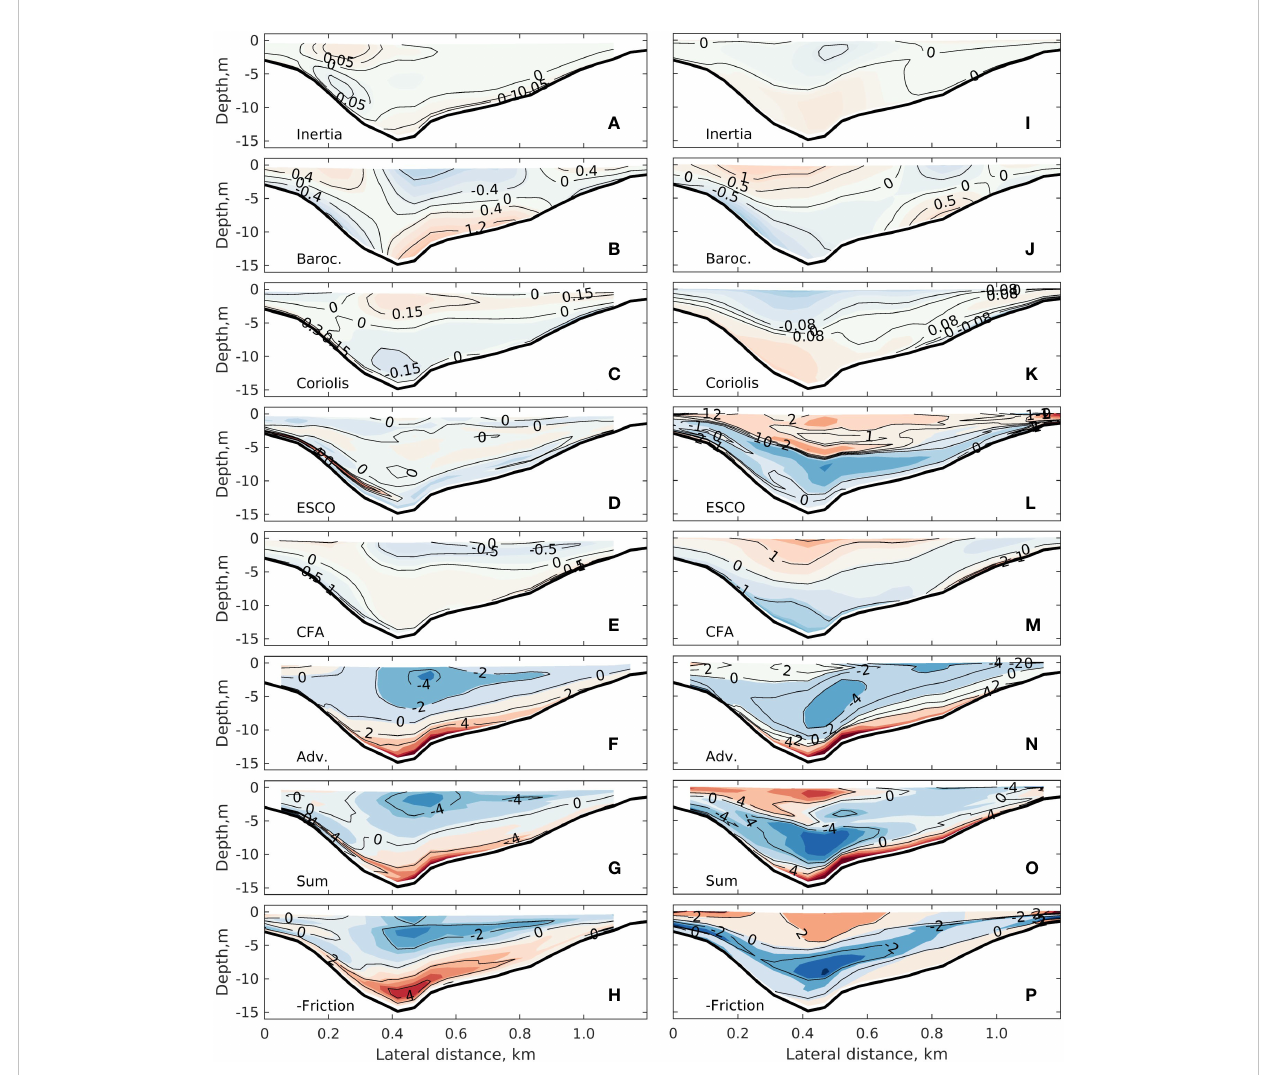
FIGURE 6 Transverse distributions of the individual terms of the subtidal lateral momentum balance during (left column) neap tide and (right column) spring tide: (A, I) local derivative inertia, (B, J) baroclinicity (Baroc.), (C, K) Coriolis, (D, L) ESCO and (E, M) CFA, (F, N) nonlinear advection (ADV). (G, O) are the summation of the above terms. To compare with the summation, (H, P) show the friction term with a minus sign. All terms have the vertical mean removed. Positive values indicate rightward momentum tendency. The unit in all contours is ×10 − 5 m s − 2